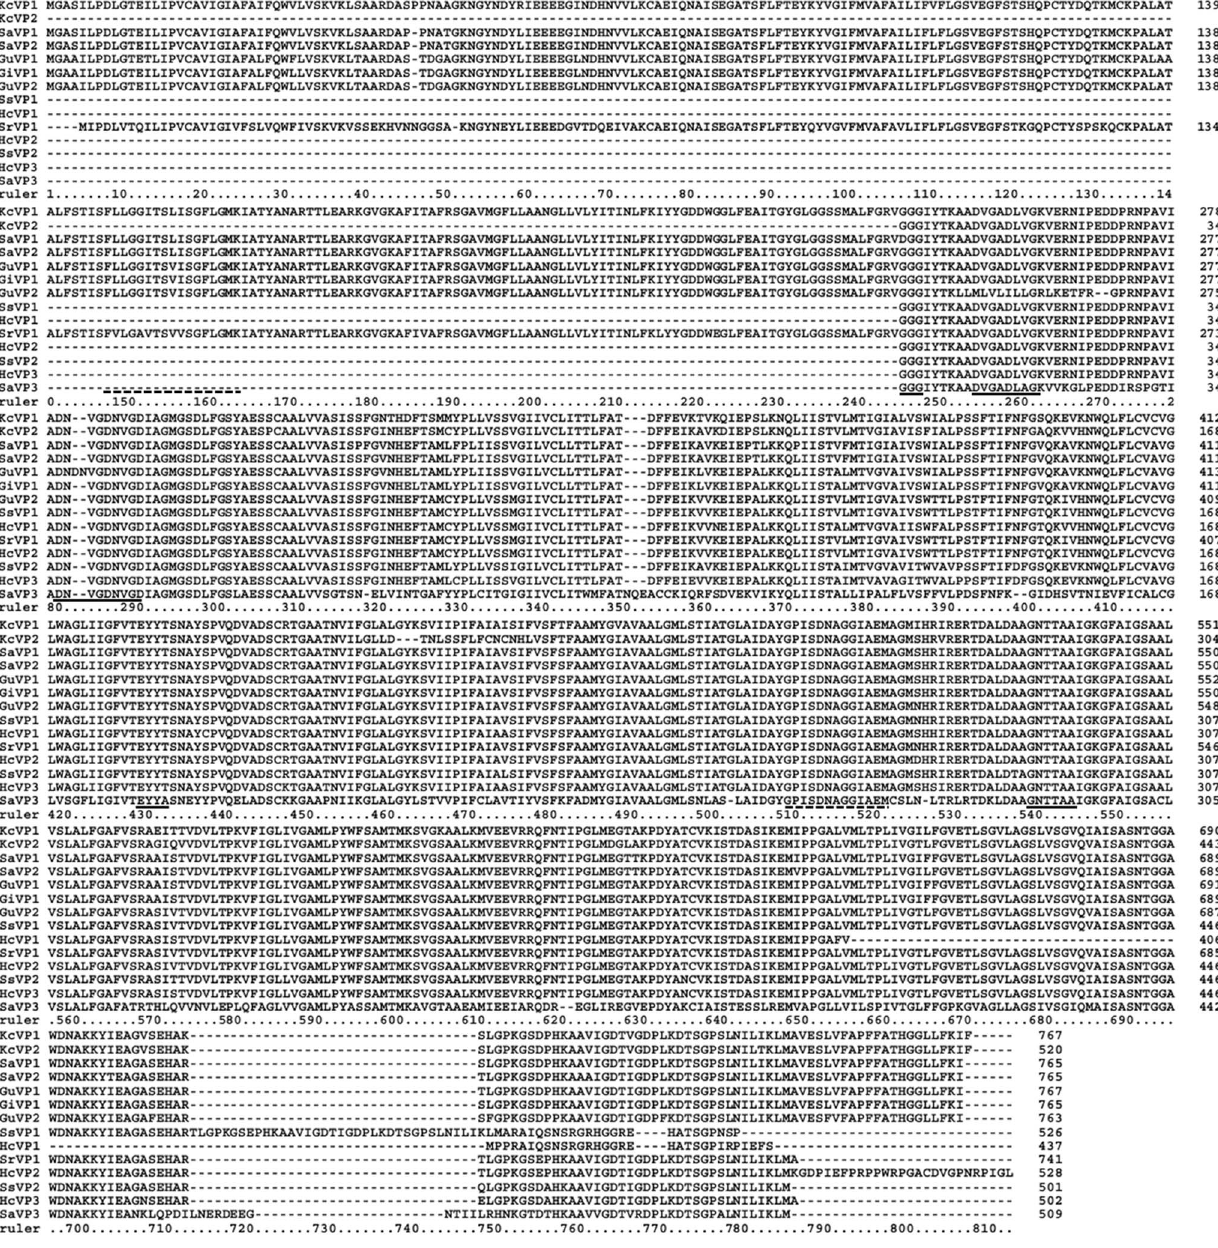
Figure 1. Multiple sequence alignment with H + -PPase sequences isolated from 7 eremophytes. Two ORFs and a fragment were from Sa ( SaVP1 , SaVP2 and SaVP3 ). The two ORFs were from Gu ( GuVP1 and GuVP2 ) and one ORF from Gi ( GiVP1 ). The two fragments were from Ss ( SsVP1 and SsVP2 ), one fragment was from Sr ( SrVP1 ), and three fragments were from Hc ( HcVP1 , HcVP2 and HcVP3 ). The other ORF and fragment were from Kc ( KcVP1 and KcVP2 ). The sequences marked with solid underline are the identified conserved domains GGG, DVGADLVGK, DNVGDNVGD, TEYYT, and GNTTAA [5,25,26]. The putative motifs GPISDNAGGIAEM and FLLGGITSLISGFLGM were marked by dotted underline.